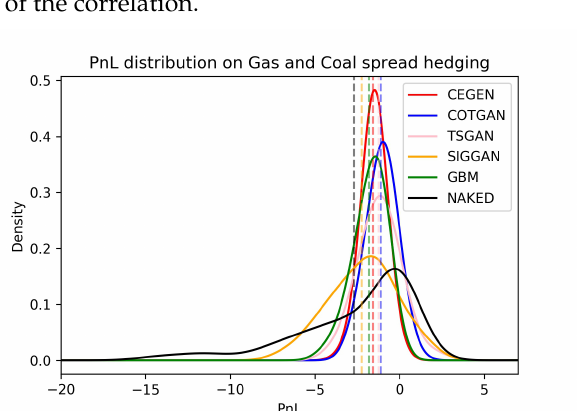
Figure 6. PnL distribution for spread option hedging. Vertical dashed lines represent the mean of the